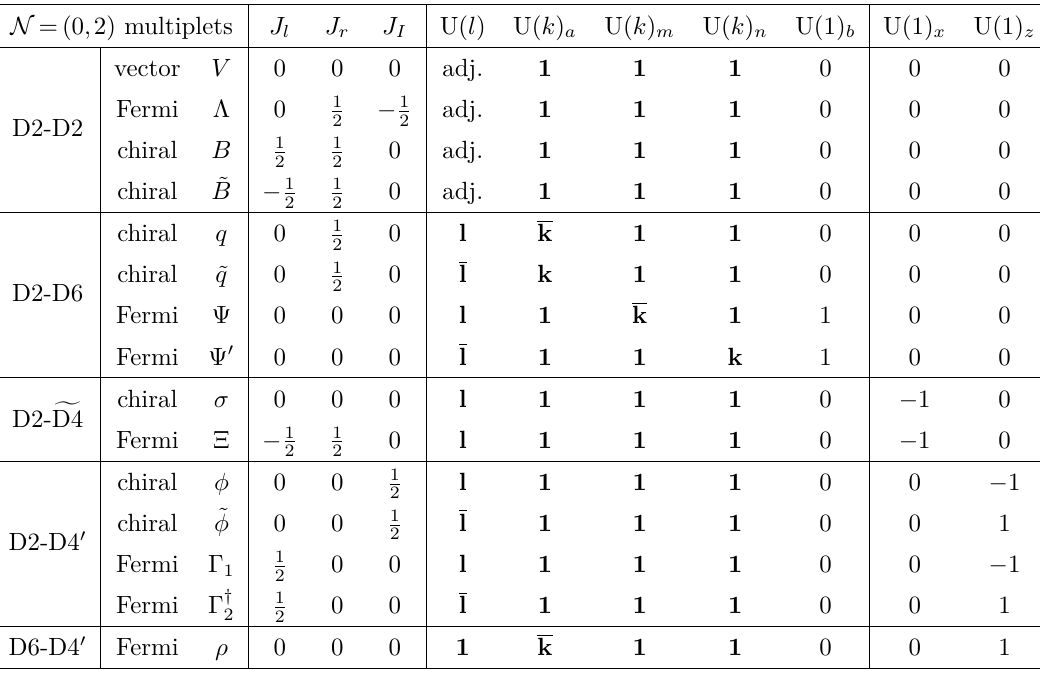
Table 2 . Charge assignments of the fields in the 2 d world-volume theory from the D2-D6-NS5 system with or without the presence of a f D4 or D 4 0 defect, see table 1. Here J l , J r , and J I denote the Cartans of SU(2) l , SU(2) r , and SU(2) I respectively. U( l ) is the 2d gauge group on the